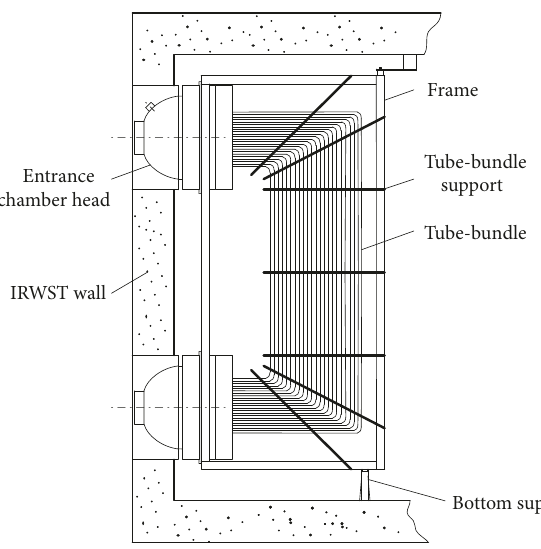
Figure 4: PRHR-HX structure